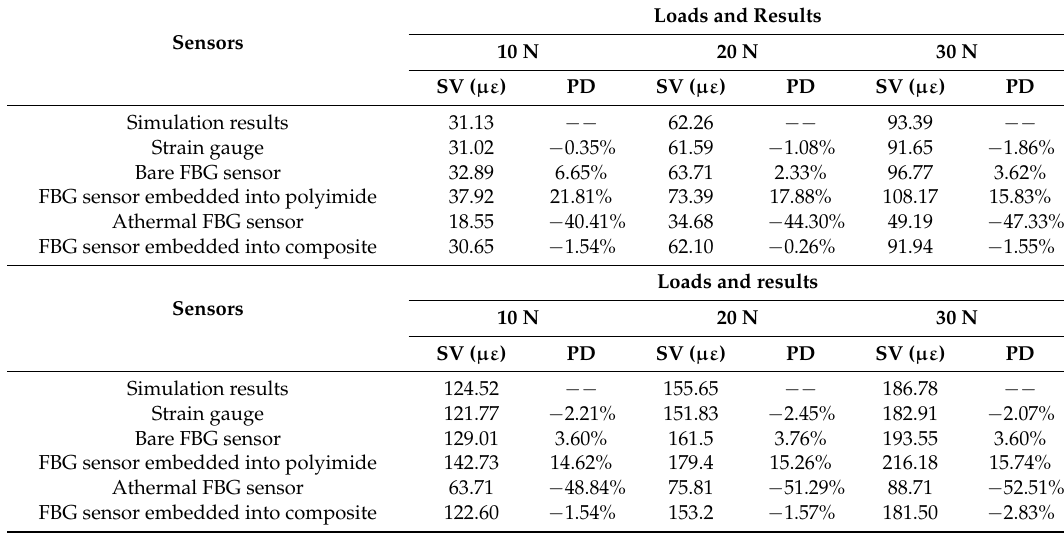
Table 1. Strain values under different loads and percentage differences compared with simulation results. Sensors